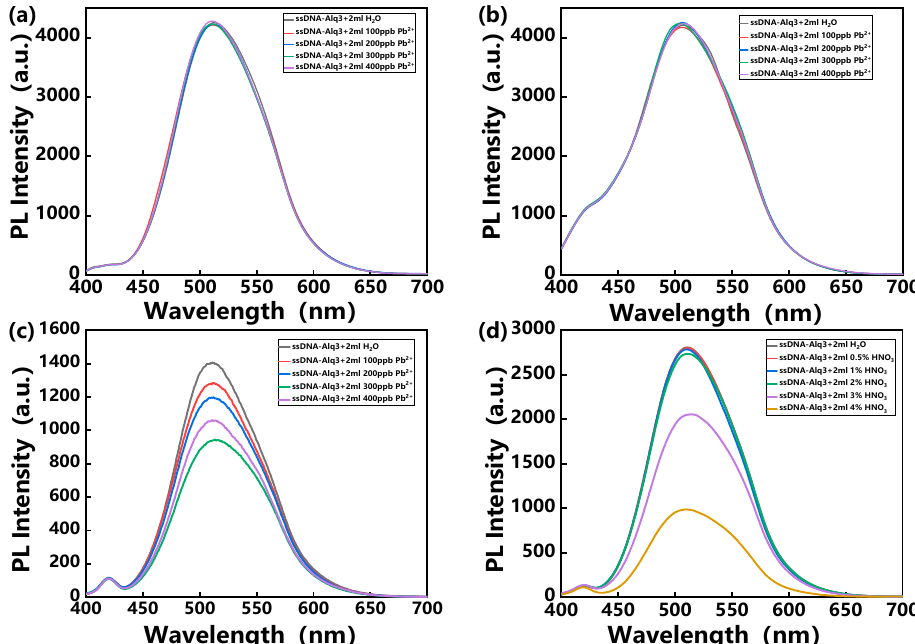
Figure 3. PL spectra of hybrid assemblies treated with ( a ) HEPES, ( b ) Tris-HCl and ( c ) MES buffer solution and exposed to various concentrations of Pb 2+ solution, with excitation at 370 nm. ( d ) PL spectra of hybrid assemblies treated with MES buffer solution treated and exposed to HNO 3 solution, with excitation at 370 nm.